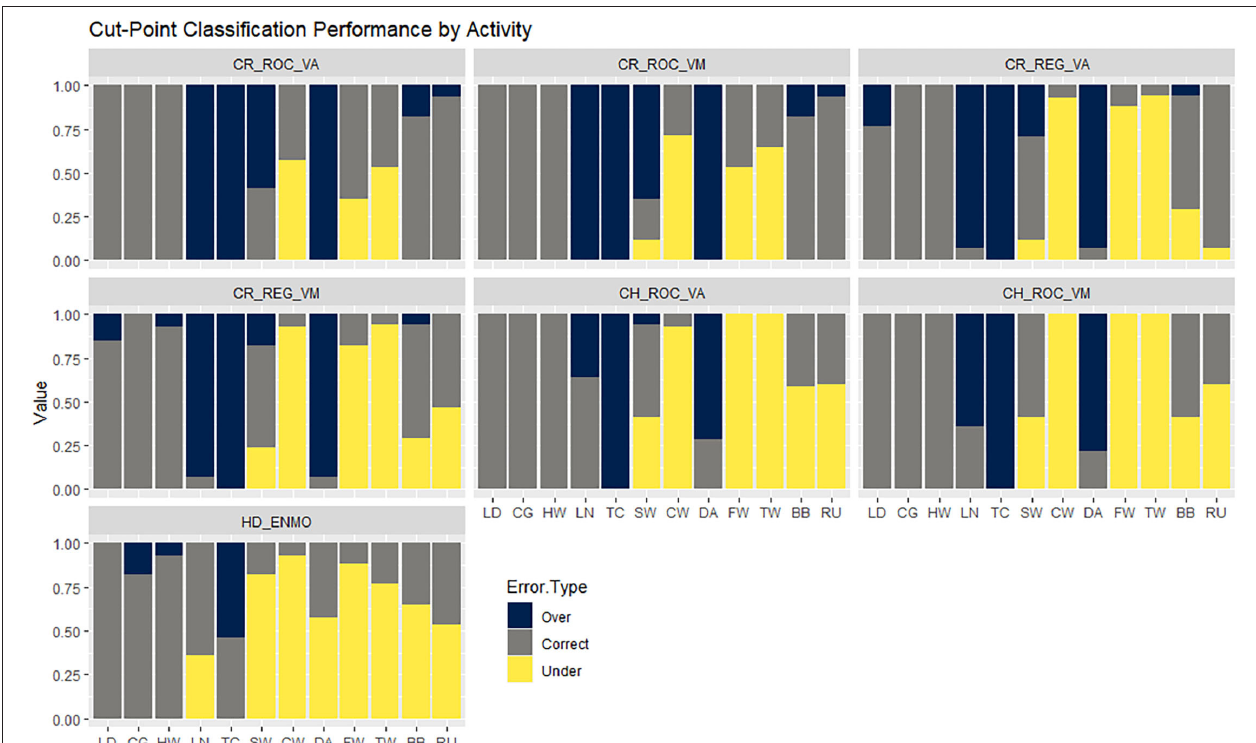
FIGURE 3 | Stacked column bar graphs summarizing the extent to which each cut-point overestimated, correctly classified, or underestimated the physical activity intensity category of each structured activity. (LD = lying down, HW = handwriting, CG = computer game, LN = laundry task, TC = throw and catch, SW = sweeping, CW = comfortable walk, DA = dance, FW = fast walk, TW = treadmill walk, BB = basketball, RU =